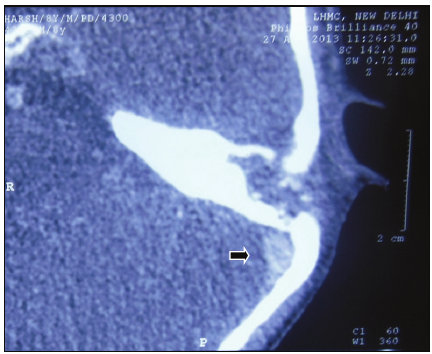
Figure 2: Contrast-Enhanced CT scan showing recanalized left sigmoid sinus